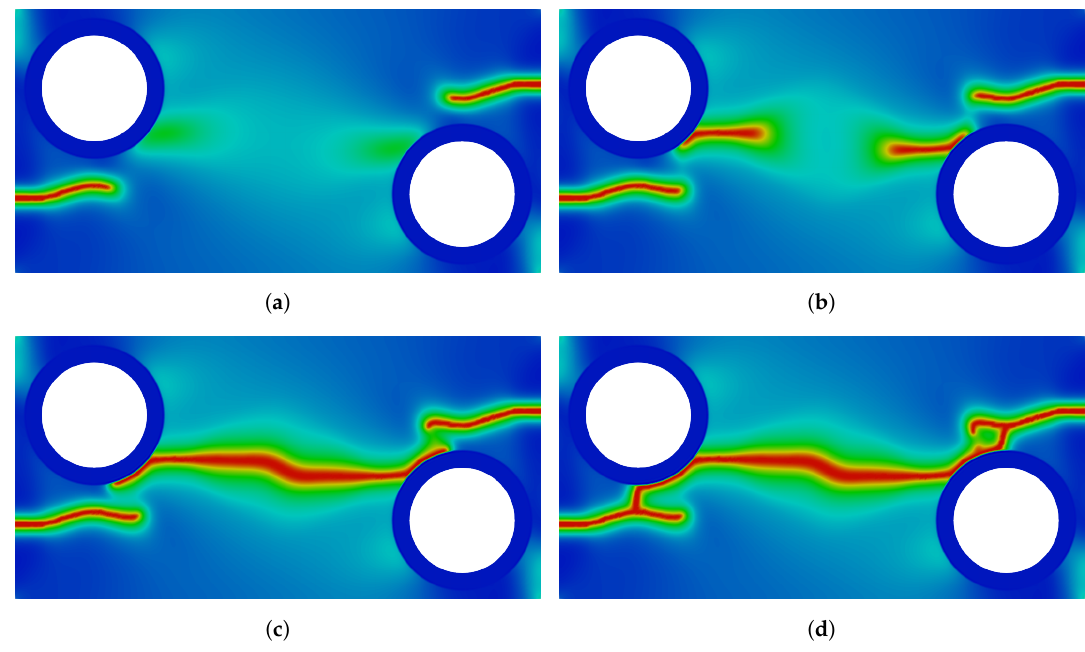
Figure 39. PFM crack path when restricting the nucleation at the holes. ( a ) Crack growth at the notches; ( b ) Crack nucleation and growth at the holes; ( c ) Joining of nucleated cracks at the holes; ( d ) Merging of notch and hole cracks.